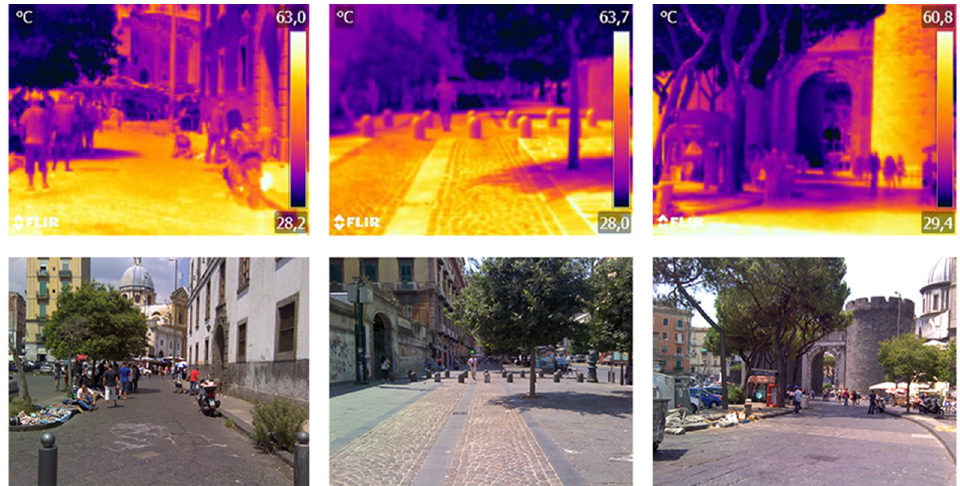
Figure A4. Thermographic surveys of the 6 August 2014 of San Francesco di Paola Square (P13), Foria Street (P17), Largo Porta Capuana (P15).